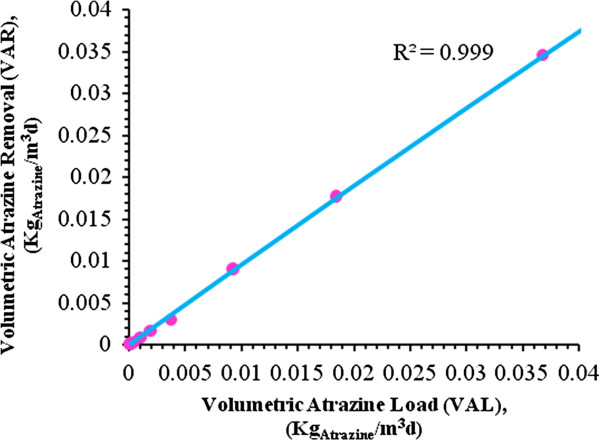
Atrazine loading of the bioreactor in the range of 0 to 0.04KgAtrazine/m3d at 32°C.